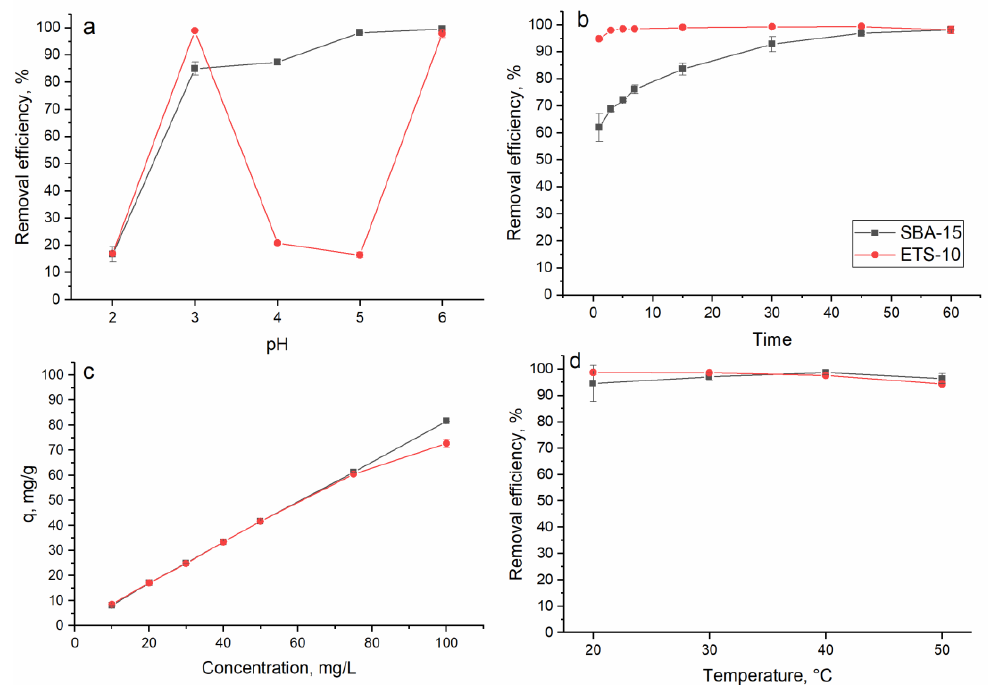
Figure 4. Effect of ( a ) pH (C i,In 10 mg/L, time 60 min, temperature 22 °C), ( b ) time (C i,In 10 mg/L, pH 3.0 for ETS-10 and 5.0 for SBA-15, temperature 22 °C), ( c ) indium concentration (pH 3.0 for ETS-10 and 5.0 for SBA-15, time 60 min, temperature 22 °C) and ( d ) temperature (C i,In 10 mg/L, pH 3.0 for ETS-10 and 5.0 for SBA-15, time 60 min 22 °C) on the adsorption of indium ions on studied sorbents. The silica SBA-15 behaved differently compared to titanosilicate ETS-10. The sorbent removal capacity increased from 85% at pH 3.0 to 99% at pH 6.0. According to [28], the nanomesoporous SBA-15 molecular sieve has the optimum adsorption effect for metal